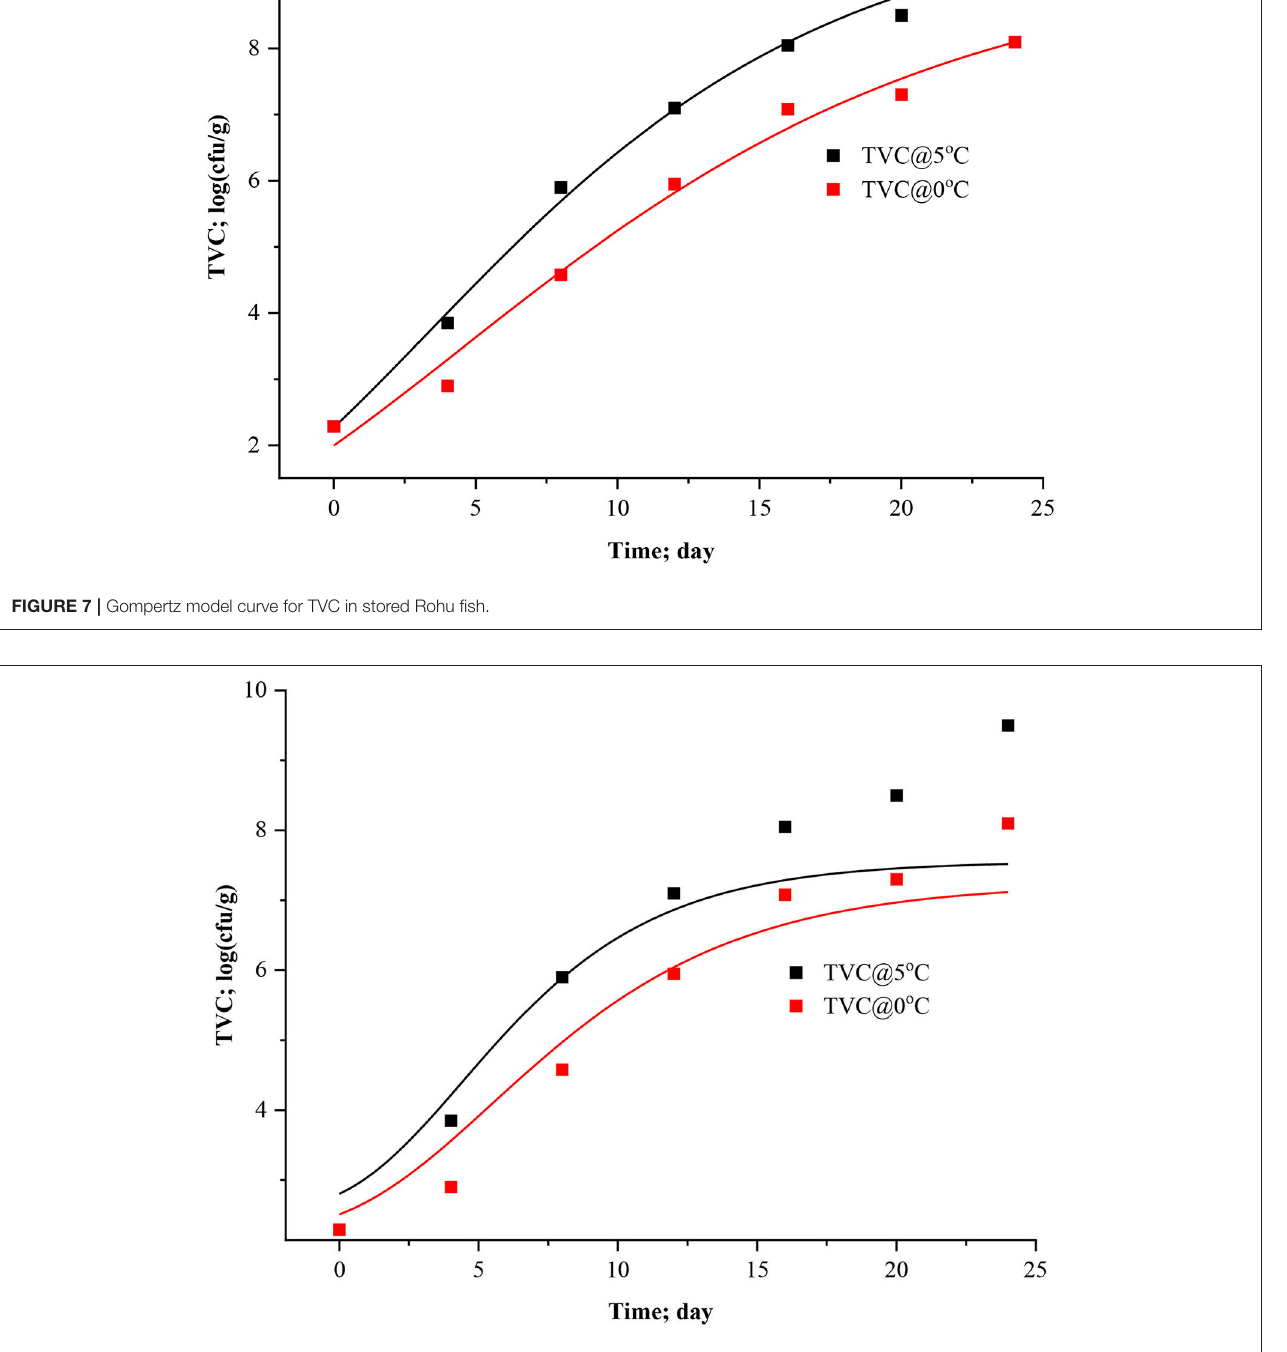
The Gompertz model’s carrying capacity (c) was found to be ranged from 3.3349 ± 0.4799 and 4.4769 ± 1.2541. The maximal growth rate ( µ max ) values were 0.4602 ± 0.41115 and